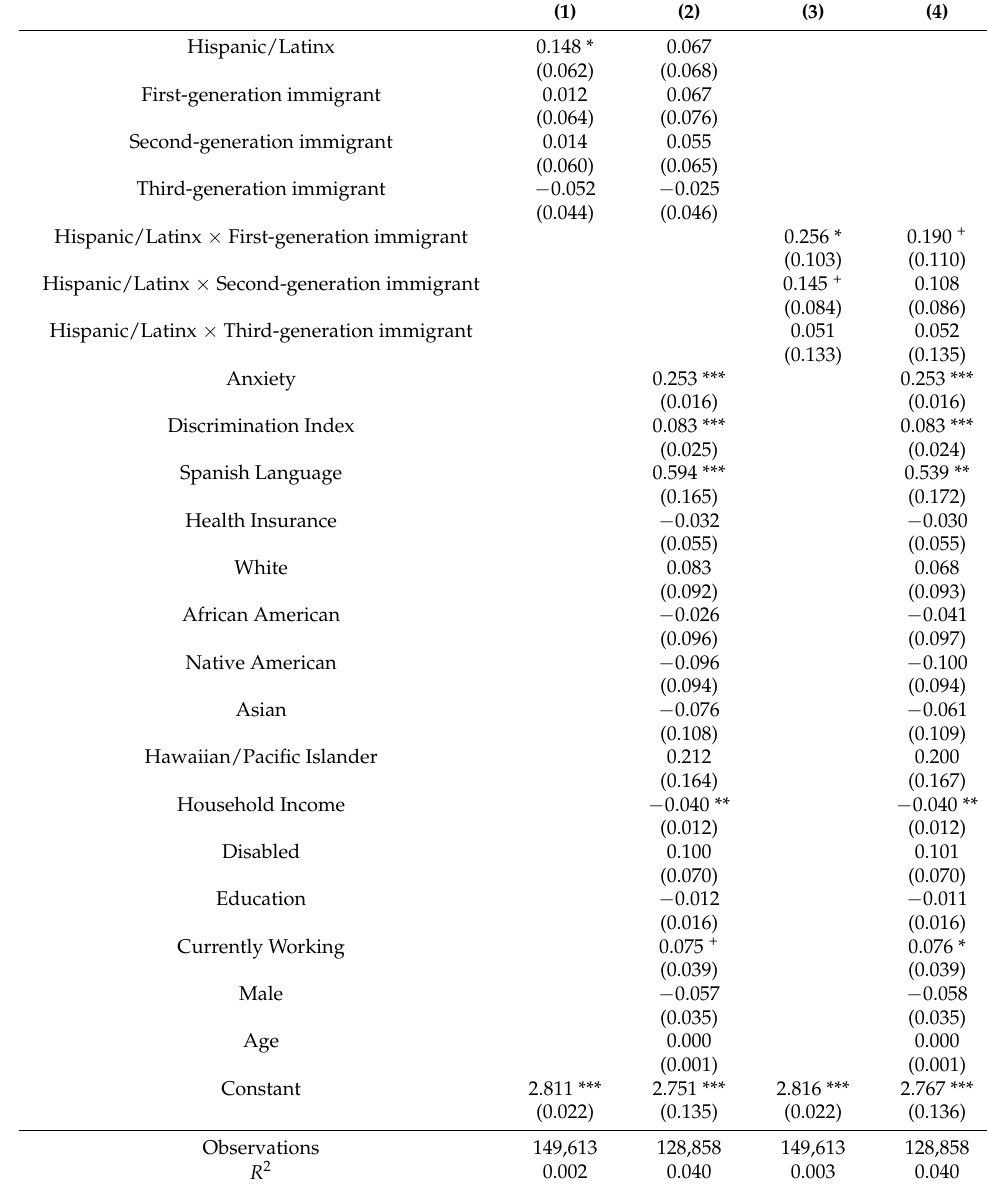
Table 2. Perceived Risk of